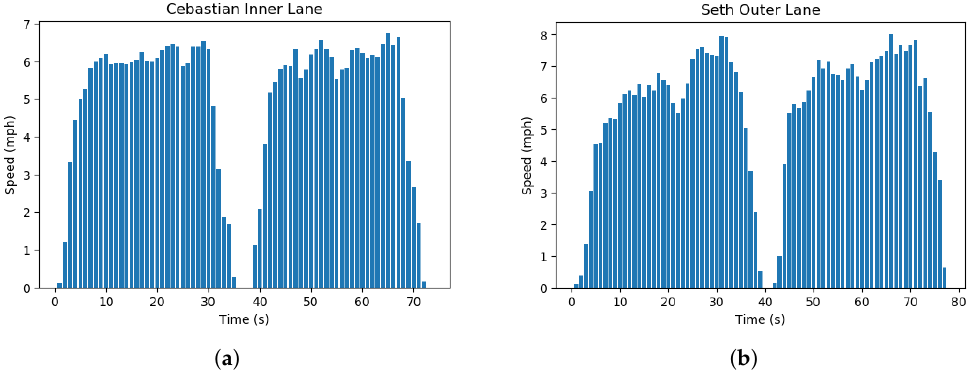
Figure 24. The above images show the speed-time graph for the best human drivers for inner lane and outer lane. The time taken, distance traveled above the speed limit, and average speed were taken into account for determining the best human driver.